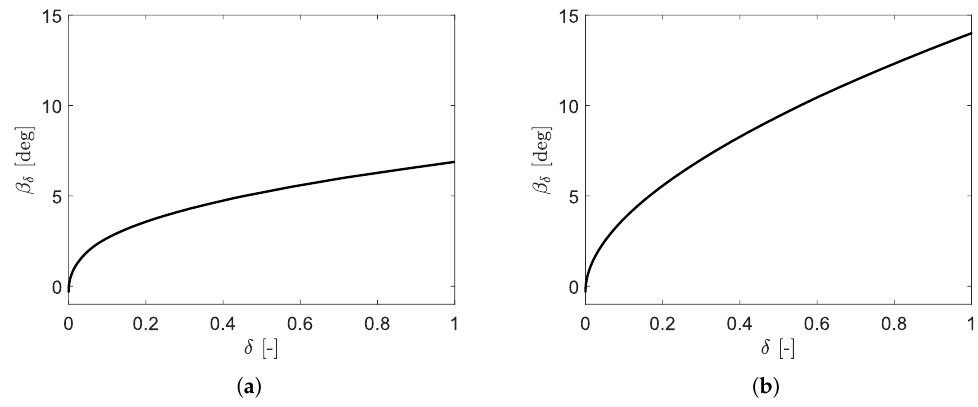
Figure 9. β δ ( δ ) tables for NREL 5-MW ( a ) and DTU 10-MW ( b ) reference turbines.